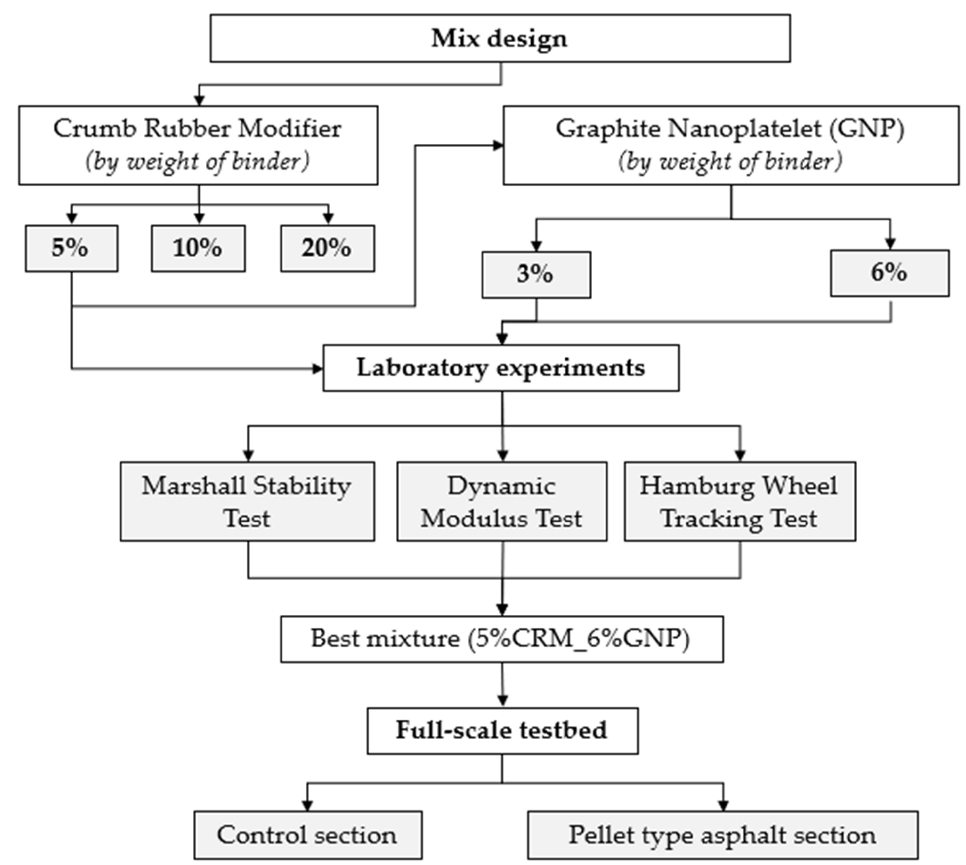
Figure 1. Testing flowchart.